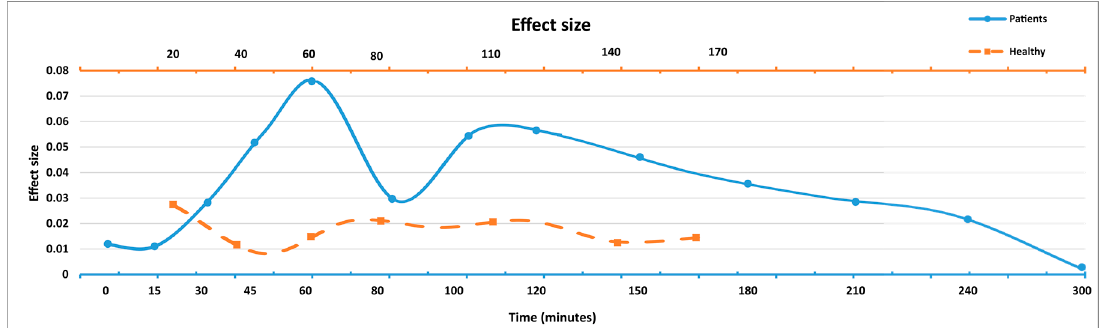
Figure 3. Sensitivity assessment of TIS across the test occasions. The lower x axis represents the minutes after taking the levodopa dose for patients and the upper x axis represents the tests time points for healthy subjects. The first data point in the x axis represents the difference in scores between first (baseline) and second measurements; the second data point represents the difference in scores between first and third measurements, and so on. Number of patients for periods: 0 ( n = 19), 15 ( n = 19), 30 ( n = 19), 45 ( n = 19), 60 ( n = 18), 80 ( n = 18), 100 ( n = 18), 120 ( n = 18), 150 ( n = 18), 180 ( n = 17), 210 ( n = 15), 240 ( n = 13), 300 ( n = 9). Test 15 at 360 min contained only one patient, which was not enough to be included in this analysis. Number of healthy subjects for periods: 20 ( n = 22), 40 ( n = 22), 60 ( n = 22), 80 ( n = 22), 110 ( n = 22), 140 ( n = 22), 170 ( n = 22).